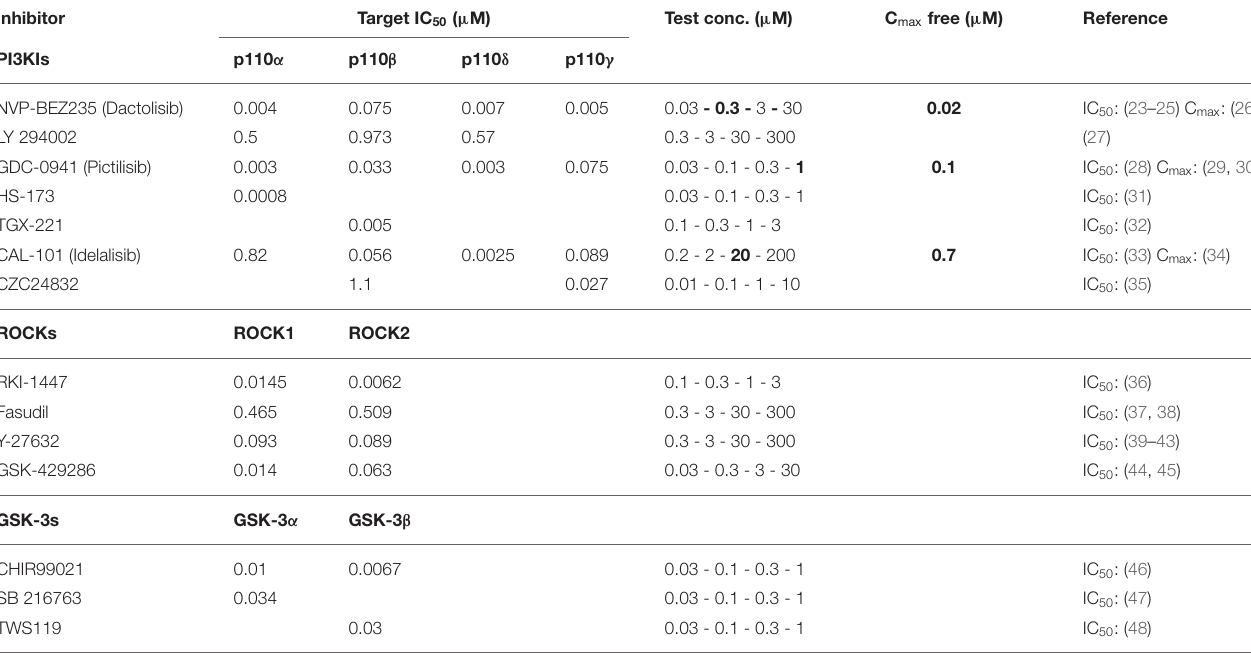
TABLE 3 | Compound biological activity and efficacy information.